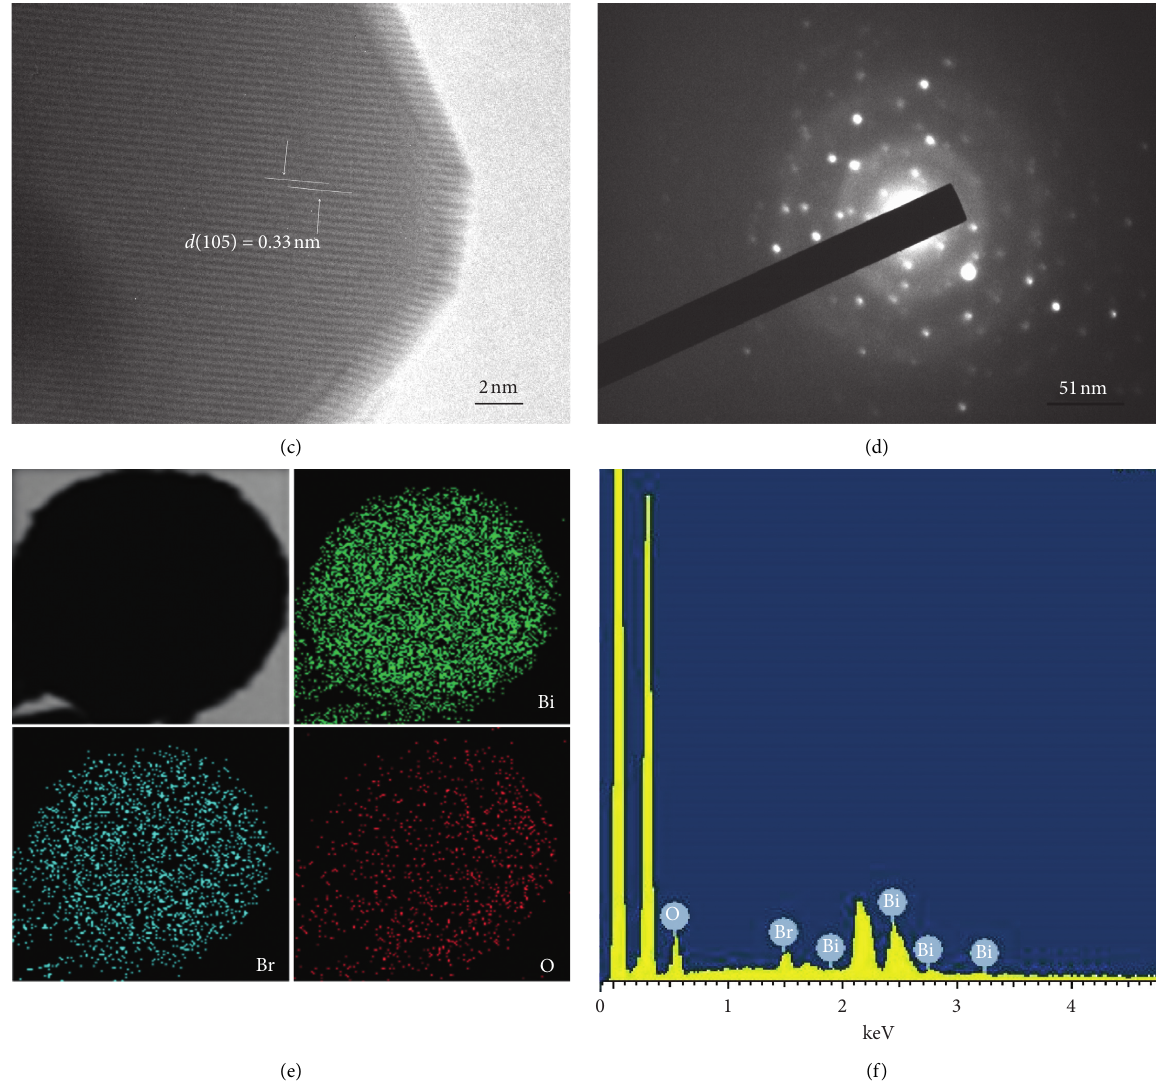
Figure 4: (a, b) TEM, (c) HRTEM images, (d) SAED pattern, (e) STEM and corresponding elemental (Bi, O, and Br) mapping images, and (f) EDS spectrum of the the red rectangle region in Figure 4(b), the clear lattice fringes with a spacing of ∼ 0.33 nm correspond to the interplanar distance of (105) plane of the tetragonal BiOBr.